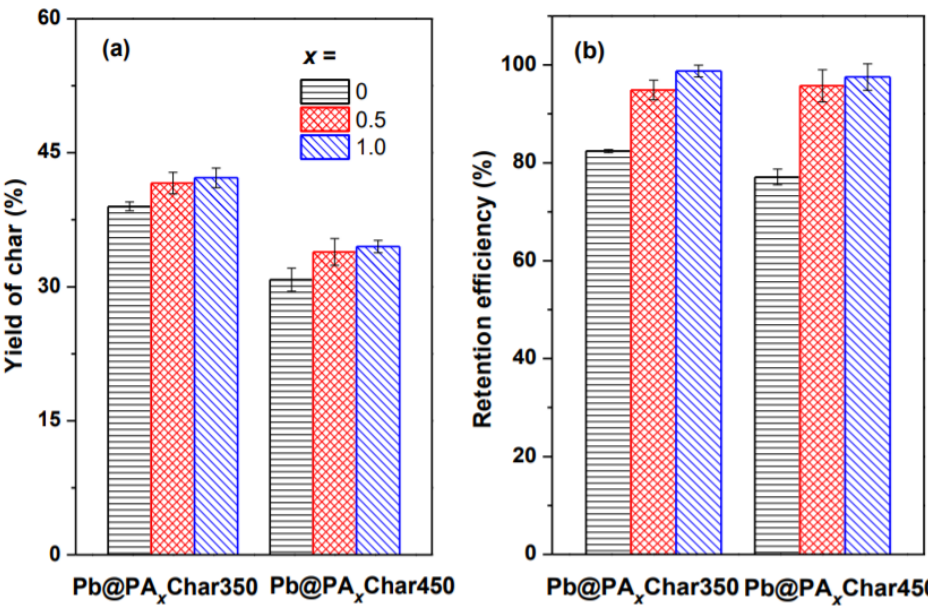
Figure 4. ( a ) Yield of chars, and ( b ) retention efficiency of Pb in the chars obtained by pyrolysis of Pb-contaminated biomass pretreated with various dosages of PA (0, 0.5 and 1.0 g/g